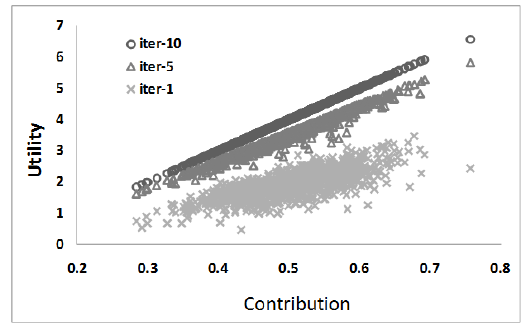
Fig. 9. The evolution of the utilities of individual peers versus their contribution values.